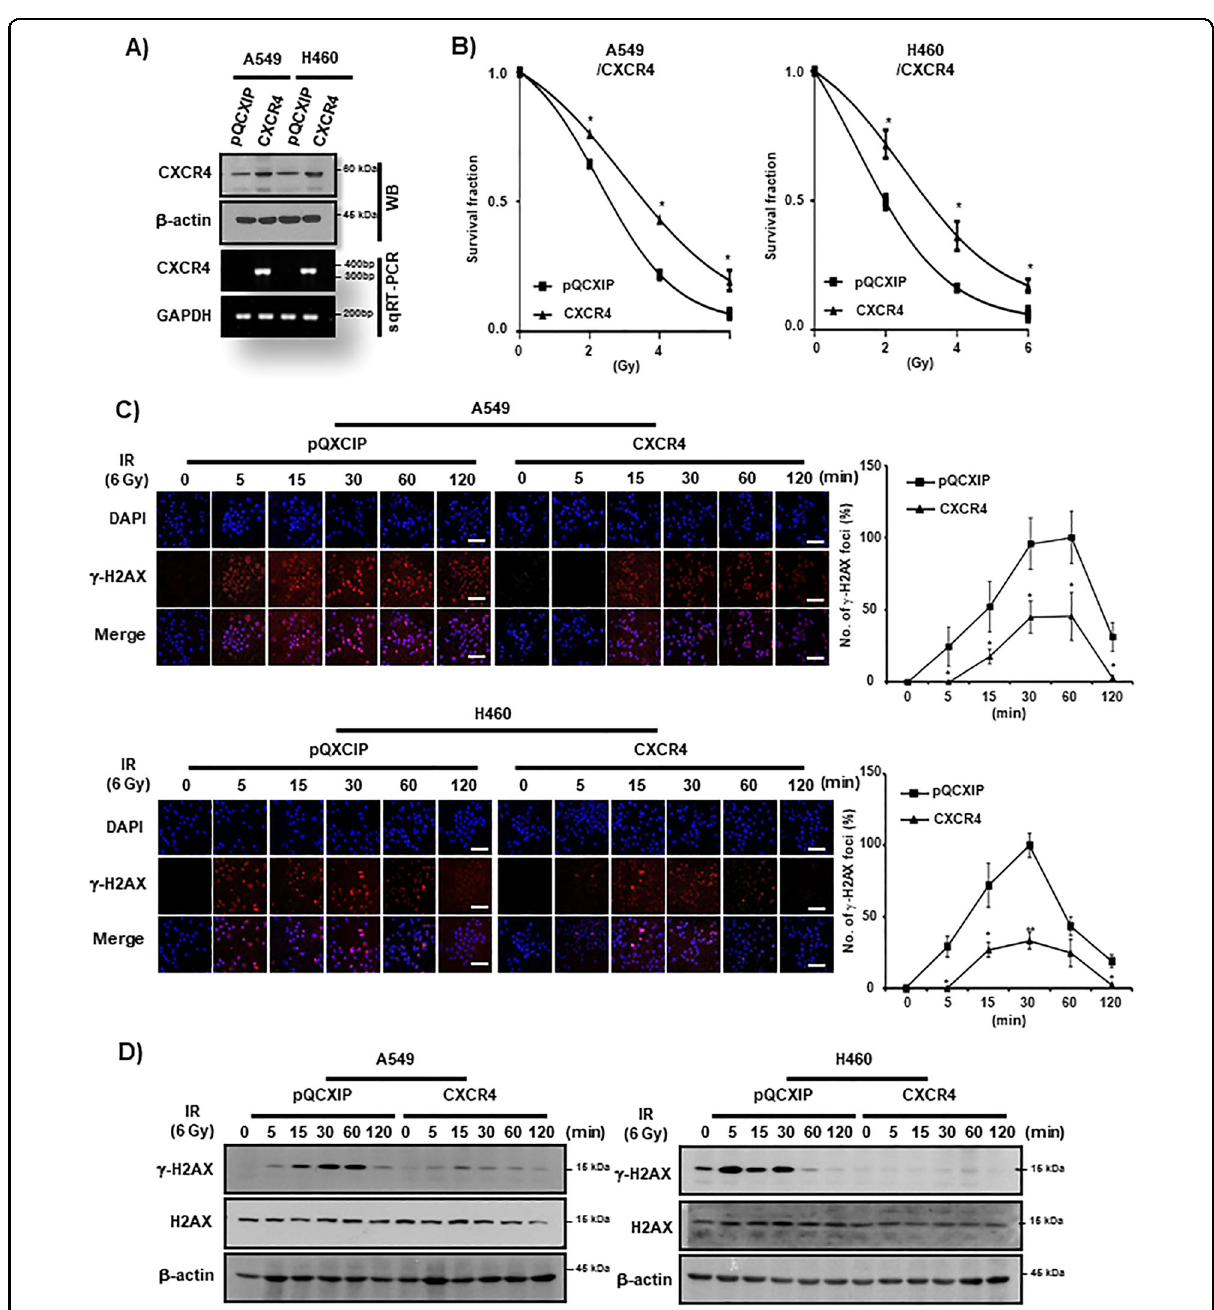
Fig. 3 CXCR4 upregulation enhances IR resistance in NSCLC cells. A Western blot (WB, upper) and RT-PCR (lower) analysis of NSCLC cells (A549 and H460) transfected with CXCR4. β -actin and GAPDH were used as a loading control for Western blot and RT-PCR, respectively. B IR clonogenic survival assay of control vector (pQCXIP) and CXCR4 overexpressing (CXCR4) NSCLC cells. Cells were exposed to IR at the indicated dose in the Figure. C γ -H2AX foci assay of A549 (upper) and H460 (lower) cells. Cells were transfected either with control vector (pQCXIP) or pQCXIP-CXCR4 (CXCR4) and were exposed to IR (6 Gy) and fi xed at the indicated time points in the Figure. Representative ICC images of γ -H2AX (left) and quanti fi cation of the results (right). Nuclei were counterstained with DAPI (blue). White bar: 20 μ m. * P < 0.05, ** P < 0.01. D Western blot analysis of A549 (left) and H460 (right) cells exposed to IR (6 Gy) at the indicated time points transfected with control vector (pQCXIP) or pQCXIP-CXCR4 (CXCR4). H2AX and β -actin were used as loading